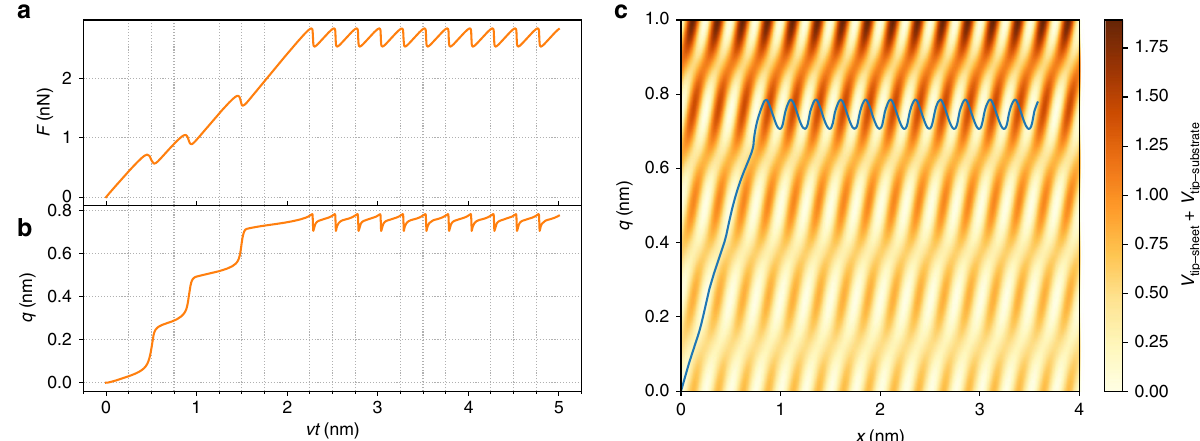
Fig. 2 Typical behaviour of our model. a Lateral force as a function of time, b sheet distortion as a function of time, and c a trajectory in xq -space showing the position of the tip and simultaneous distortion of the sheet. The strengthening is similar in behaviour to that found in experiments 4 and detailed simulations 10 . The frictional strengthening is coupled to, and limited by, the sheet distortion. The strengthening behaviour of the system can be understood from the potential